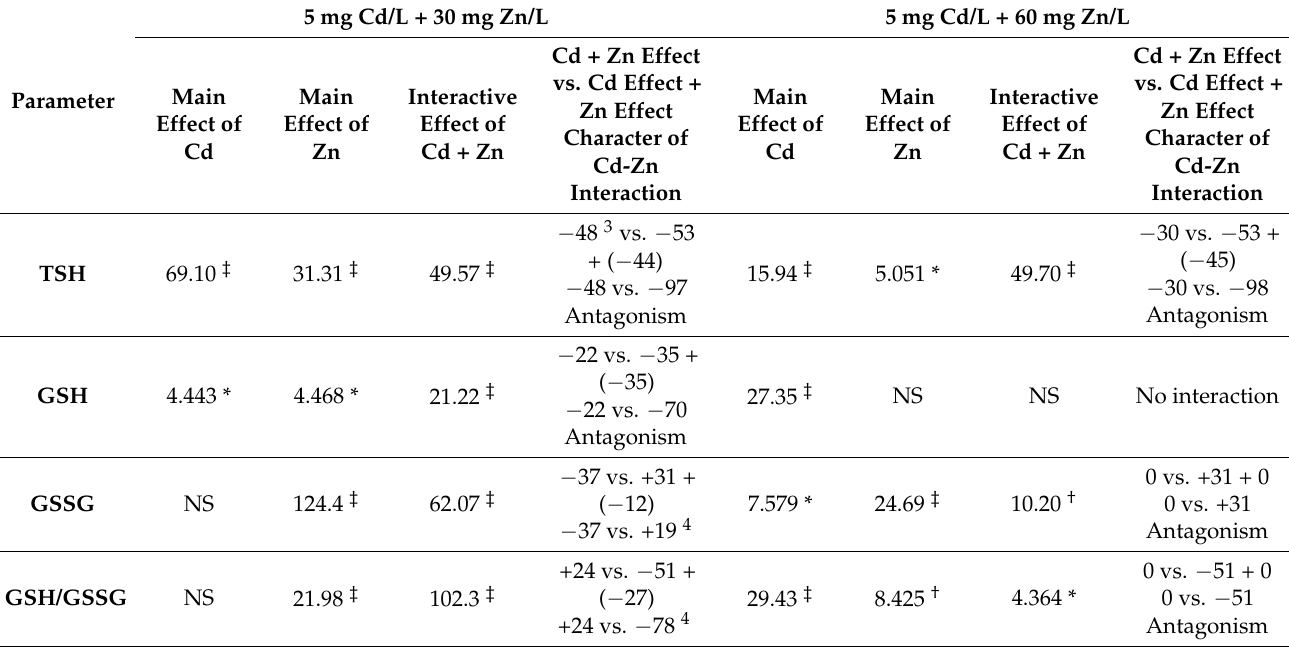
Table 3. Interactive and main effects of cadmium (Cd) and zinc (Zn) on the concentrations of total thiol groups (TSH), reduced glutathione (GSH), and oxidized glutathione (GSSG), as well as the GSH/GSSG ratio in the brain tissue of male rats 1,2 .